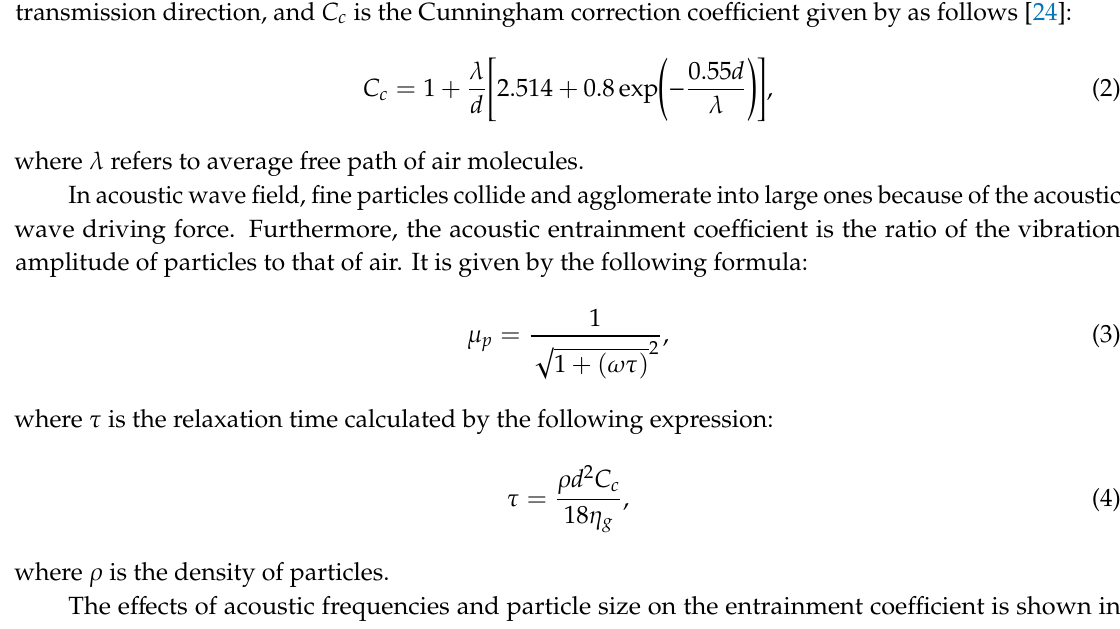
Figure 3. Relationship between entrainment coefficient, particle size, and frequency of particles.